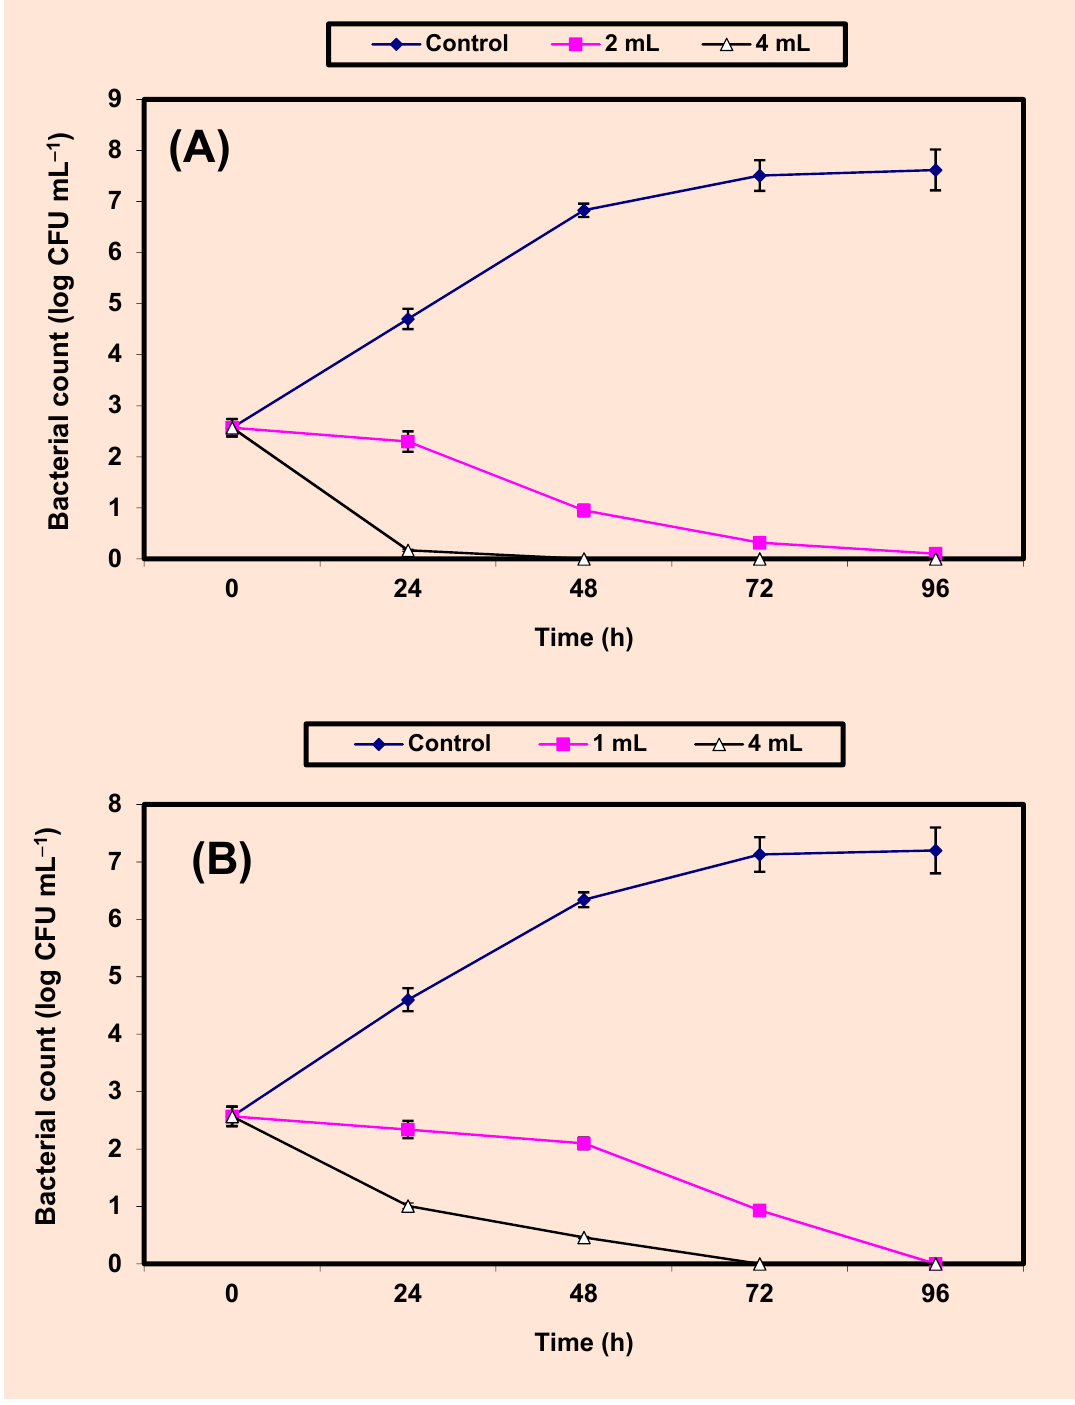
Figure 4. Inhibition of both S. aureus ( A ) and Sal. typhimurium ( B ) in apple juice. Symbols ♦ , ■ , ∆ , refer to control untreated samples, samples treated with 2%, 4% KB, respectively.